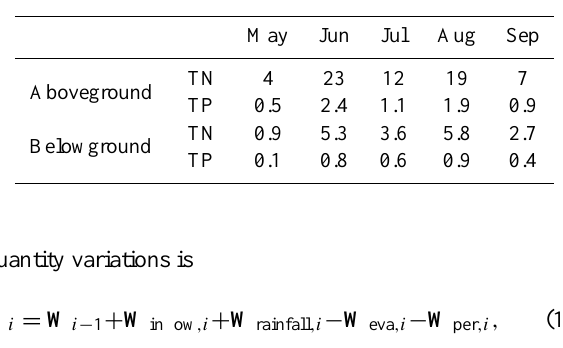
Table 1. Amount of nutrients absorbed by aboveground and below- ground parts of reeds per unit area each month during the growing season in Baiyangdian Lake (gm − 2